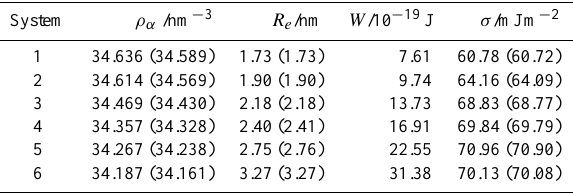
Table 2. Calculated liquid density, radius for equimolar dividing surface, work of formation, and surface tension for spherical inter- faces in systems 1–6. Shown in parentheses are the data calculated by fitting to the error function.